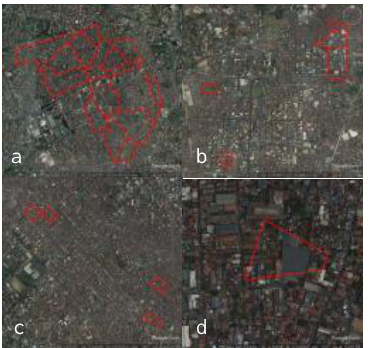
Figure 6. Intra-Urban Heat Islands (IUHI) in the barangays of (a) Quezon City, (b) Caloocan City, (c) Manila, and (d) Pasay City.